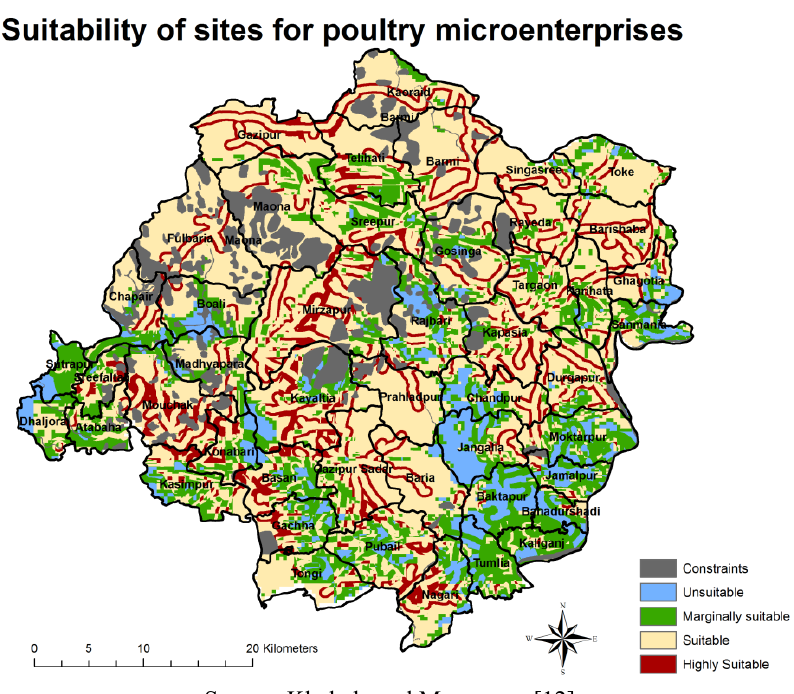
Figure 4. Map showing suitability of sites for poultry microenterprises in Gazipur.